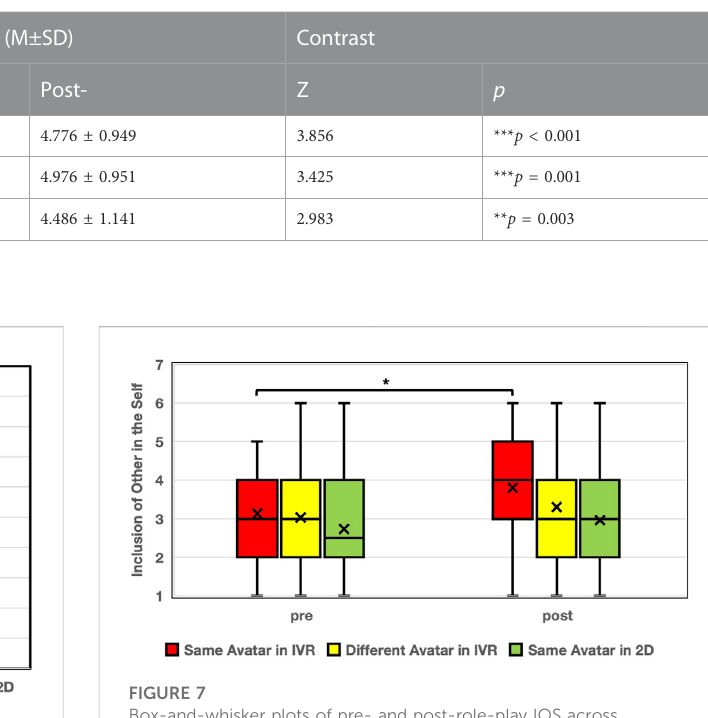
FIGURE 6 Degree of agreement with the opinion of the avatar pre- and post- role-play (G1: Same Avatar in IVR; G2: Different Avatar in IVR; G3: Same Avatar in 2D). The error bars denote standard error, *** p < .001.